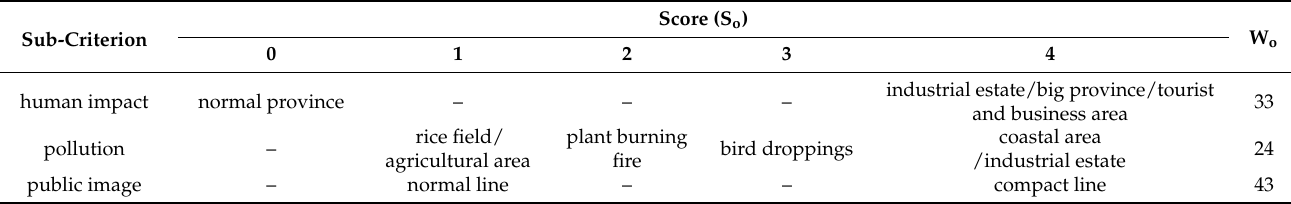
Table 8. Score and weight for the environmental criteria.